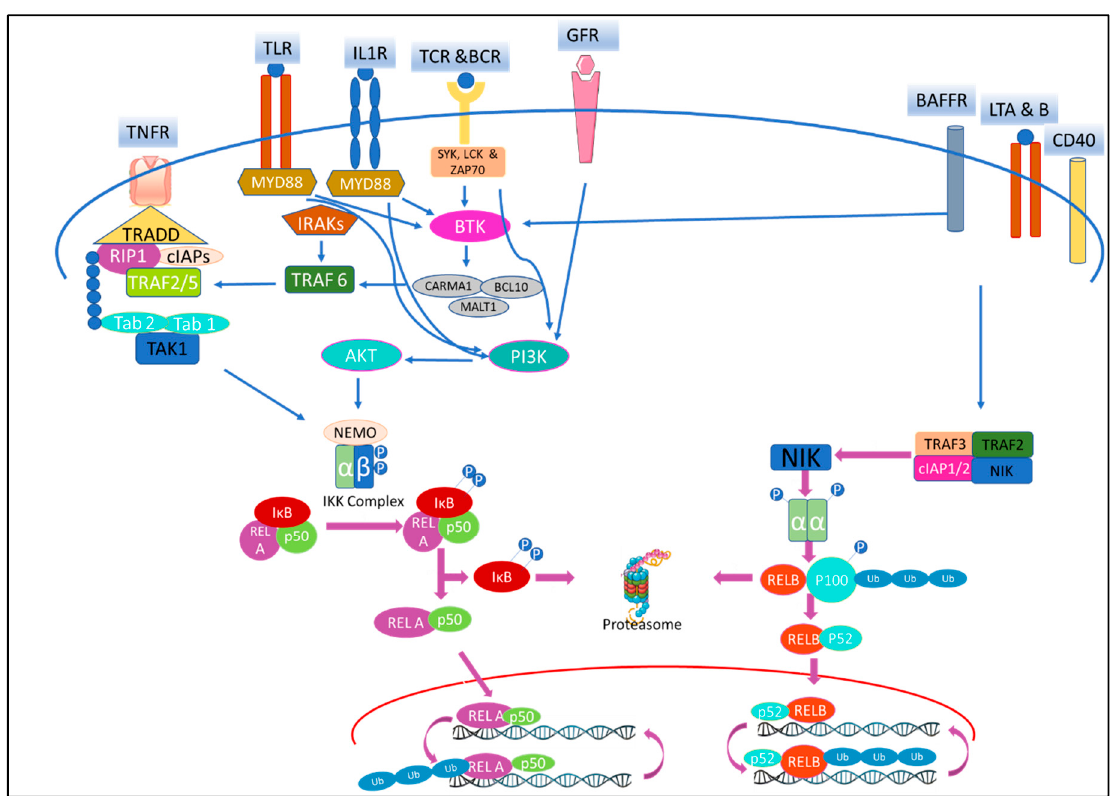
Figure 1. Schematic diagram of the canonical and non-canonical Nuclear factor kappa B (NF- κ B) signaling pathways. Canonical NF- κ B signaling cascade is initiated at the cell membrane through tumor necrosis factor – α receptor (TNFR), interleukin1 receptor (IL1R), toll-like receptor (TLR), T-cell receptors (TCR), B-cell receptors (BCR), and growth factor receptors (GFR) while the non-canonical pathway can be stimulated via receptors such as lymphotoxin α and β (LTA and B), cluster of differentiation 40 (CD40) and B-cell activating factor (BAFF). Upon stimulation of the receptor, the canonical pathway is mediated through adapter proteins and kinases that eventually activate the I κ B kinase (IKK) complex via activation of transforming growth factor β -activated kinase 1 (TAK1). Similarly, PI3K mediates signaling from GFR, TLRs, TCR, BCR, and cytokines feeds into activation of IKK via phosphorylation of AKT (protein kinase B) and IKK α . Subsequently, polyubiquitination and site-specific phosphorylation of I κ B protein via IKK complex leads to its proteasomal degradation. The released NF- κ B dimers translocate to the nucleus. Meanwhile, during the activation of the non-canonical pathway, TNF receptor-associated factor (TRAF) and cellular inhibitor of apoptosis (c-IAP) are recruited to the receptor as TRAF2/TRAF3/c-IAP1/2 complex. TRAF2/TRAF3 undergo proteasomal degradation allowing NF- κ B-inducing kinase (NIK) levels to be stabilized. NIK then phosphorylates IKK α homodimer. Activated IKK α homodimer phosphorylates p100, leading to the partial degradation of p100 to p52. RelB/p52 heterodimers translocate to nucleus for further transcription.